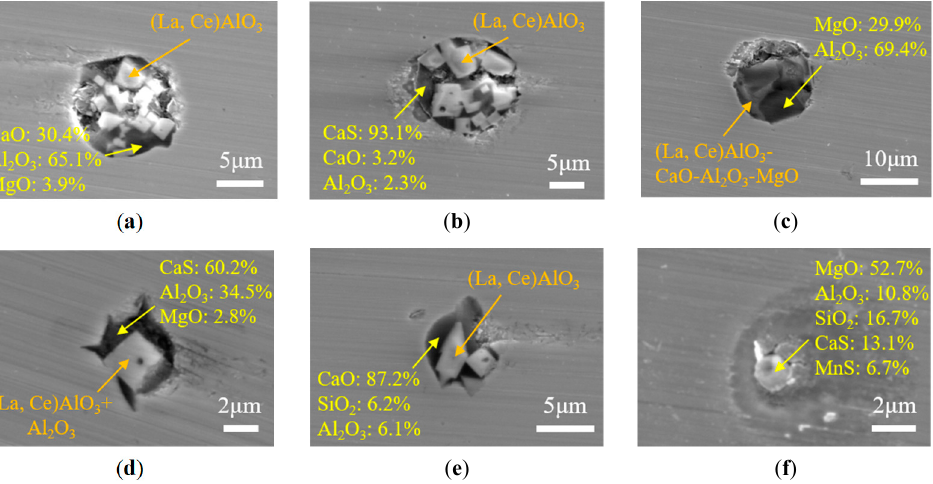
Figure 8. Typical morphologies and compositions of inclusions in the tundish pouring zone. ( a ) (La,Ce)AlO 3 +Al 2 O 3 -MgO-CaO; ( b ) (La,Ce)AlO 3 +Al 2 O 3 -CaO-CaS; ( c ) (La,Ce)AlO 3 -Al 2 O 3 -MgO- CaO+Al 2 O 3 -MgO; ( d ) (La,Ce)AlO 3 -Al 2 O 3 +Al 2 O 3 -MgO-CaS; ( e ) (La,Ce)AlO 3+ Al 2 O 3 -CaO-SiO 2 ; ( f ) Al 2 O 3 -CaS-MgO-SiO 2 -MnS.